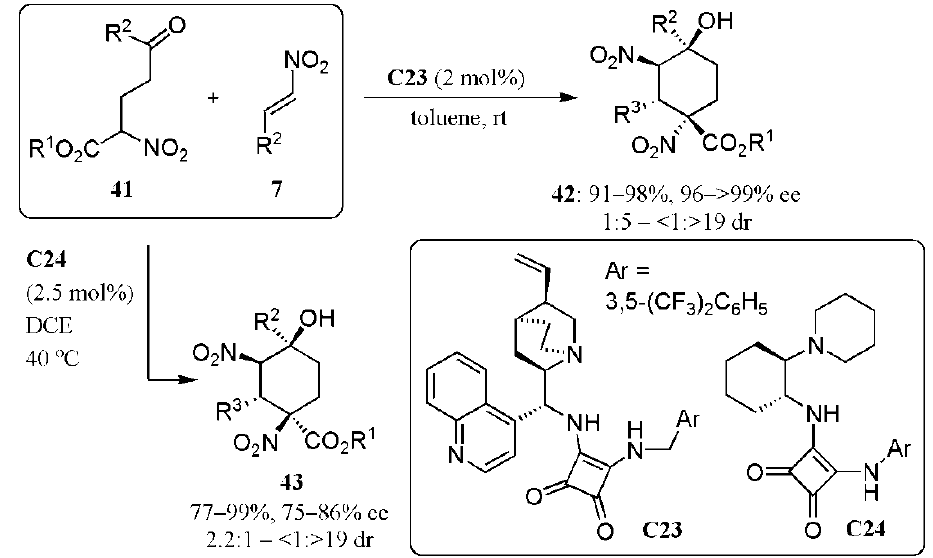
Figure 30. Diastereo-divergent synthesis of functionalized cyclohexanes [64]. Kinetic experiments were performed to find the rate-determining step, and DFT calculations were performed at the B3LYP/6-31G(d) level of theory using the PCM model to explain the reaction process and the origin of stereo-divergence. The initial Michael reaction, in which the initial two stereocenters are formed, was considered as the stereo- defining step. It is in this step that the diastereo-divergency of the reaction occurs when the two different C-1 epimers are formed with each catalyst. It was observed that the reaction was first-order for all reagents: both catalysts, nitronate 41a ( 117 , R 1 = Et, R 2 = Me), and nitrostyrene. The fact that the rate of the reaction was strongly dependent on the electronic nature of the aryl substituent of the nitroalkene also suggested that the initial Michael reaction is the rate-limiting step. Among others, an experiment was performed with a preprepared Michael intermediate, which, when stirred with either catalyst, provided the same product in comparable yields. This is a strong indication that although the configuration of the two stereocenters generated during the initial Michael reaction step is controlled by the catalyst, the diastereoselectivity of the intramolecular Henry reaction is strictly governed by the substrate. Hence the DFT analysis was performed for each catalyst on a simplified Michael reaction between 44 and 7b . The optimized transition state structures (TS1 and TS2) found by FDT analysis leading to the major isomer formed by each catalyst are shown in Figure